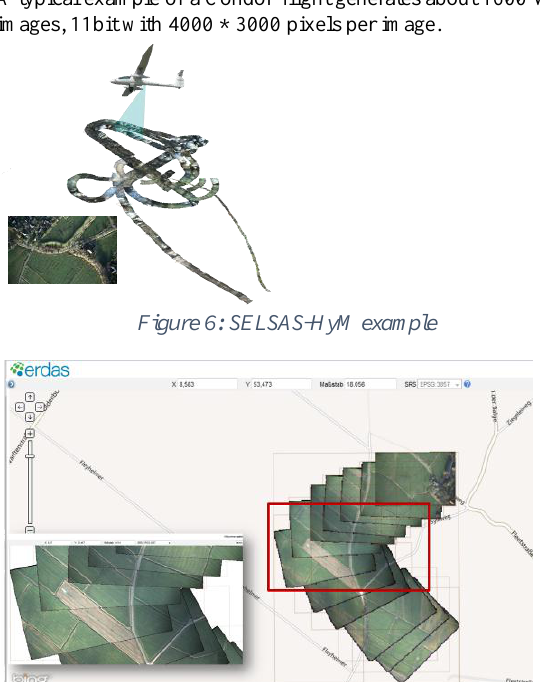
Figure 7: UAS-images as OGC-web